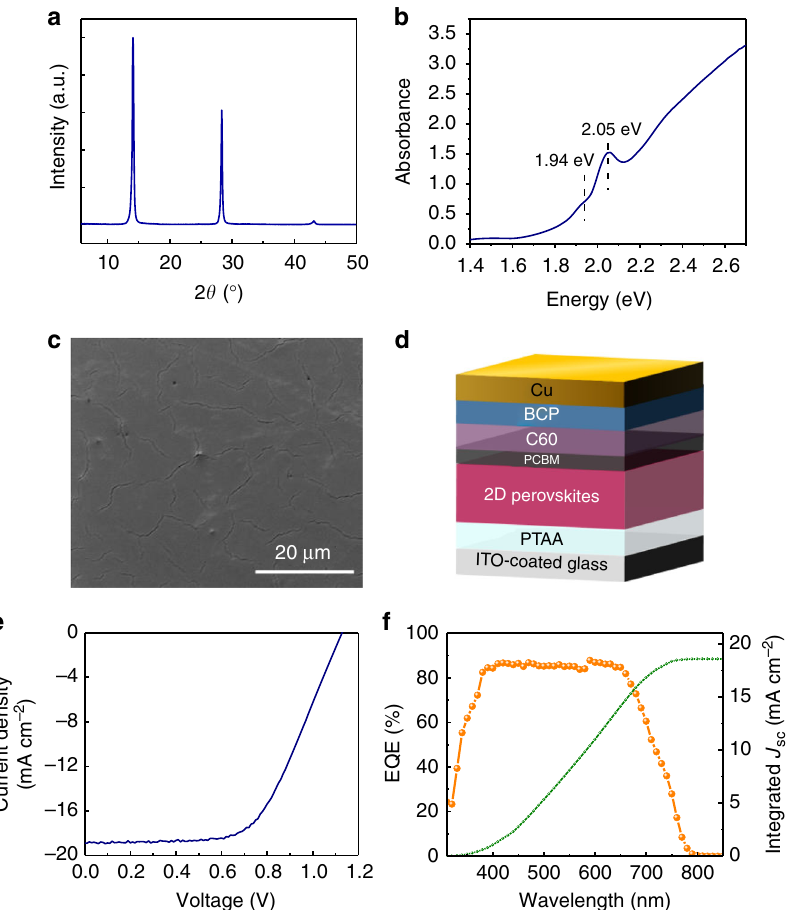
Fig. 1 Characterization of layered perovskite thin fi lms and fabricated solar cells. X-ray diffraction (XRD) spectrum ( a ), absorption spectrum ( b ) and scanning electron microscopy (SEM) image ( c ) of layered perovskites fi lms. d The layered perovskite photovoltaic device architecture. e Current density- voltage ( J-V ) curve of solar cells based on layered perovskites. f External quantum ef fi ciency (EQE; orange) and integrated short-circuit current density ( J SC ; green) as a function of wavelength for layered perovskite solar